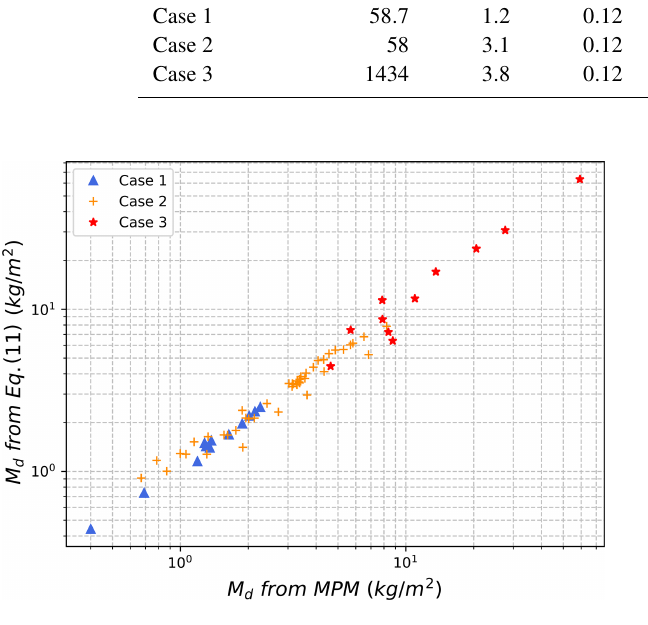
Figure 10. Evolution of the detrainment mass predicted with the model (Eq. 11) and with the observation; the coefficient of deter- mination r 2 for the model prediction on the detrainment mass is 0 . 9912.